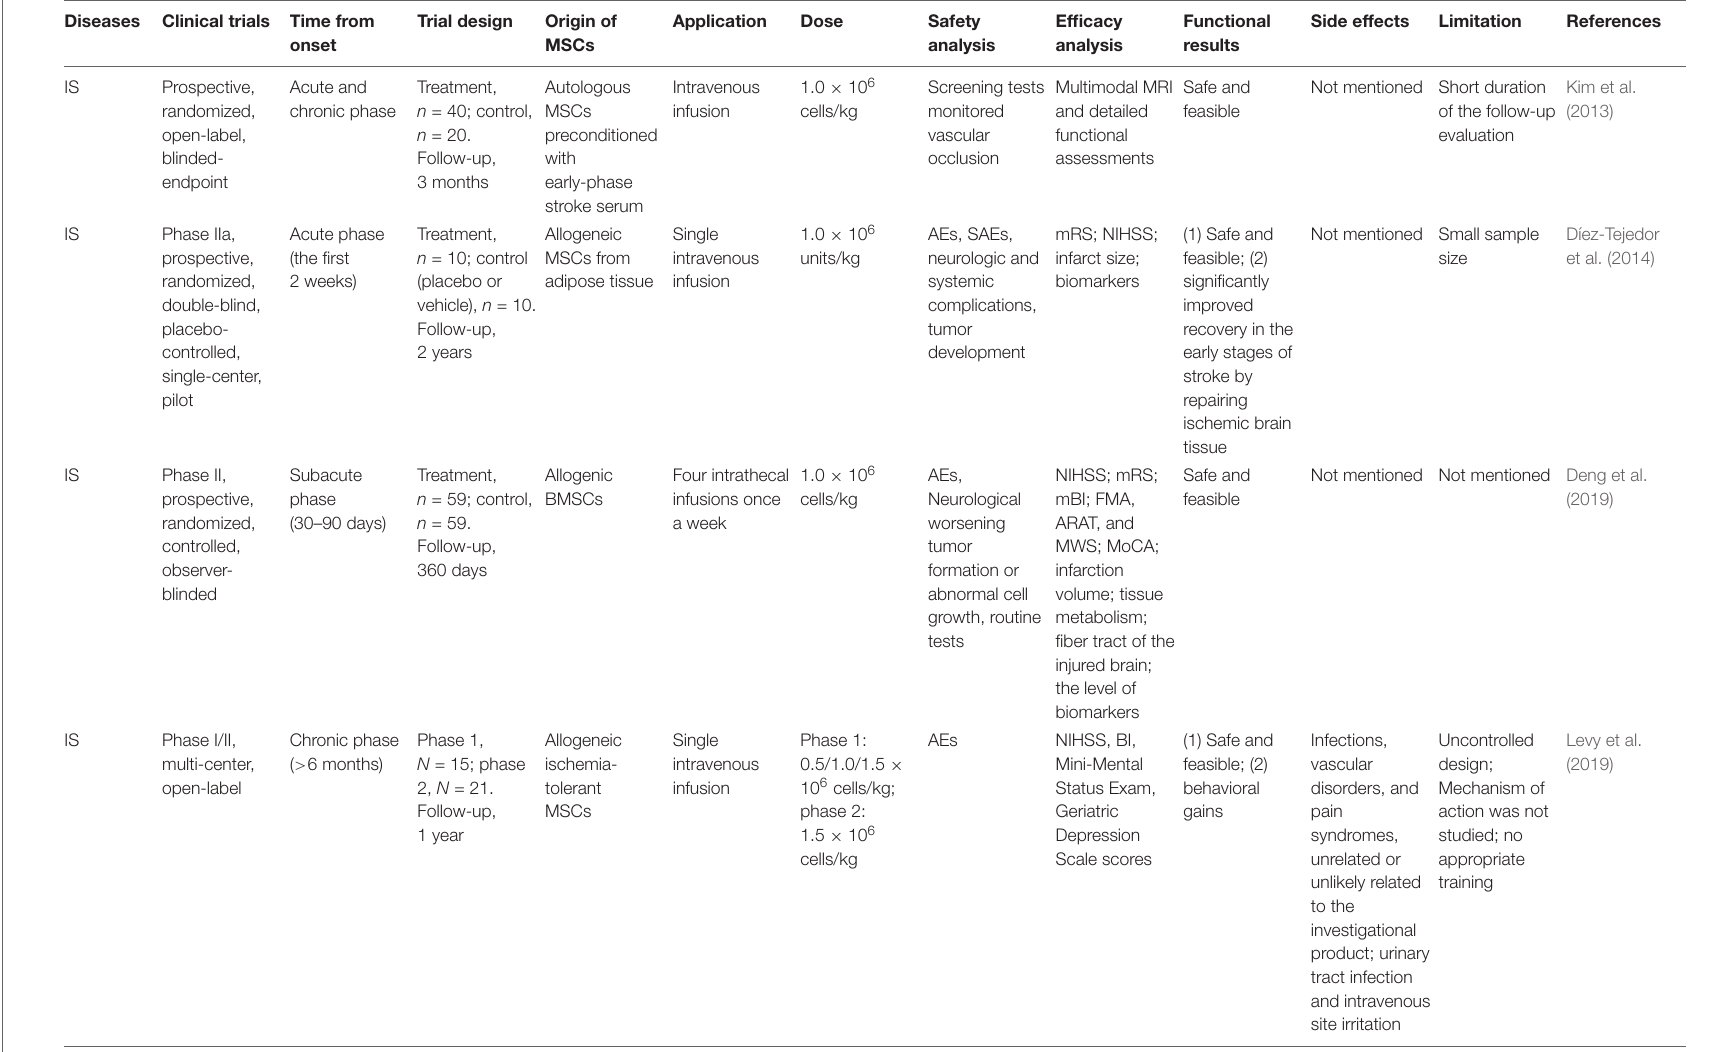
TABLE 2 | An overview of the administration of MSCs involved in clinical trials. Diseases Clinical trials Time from